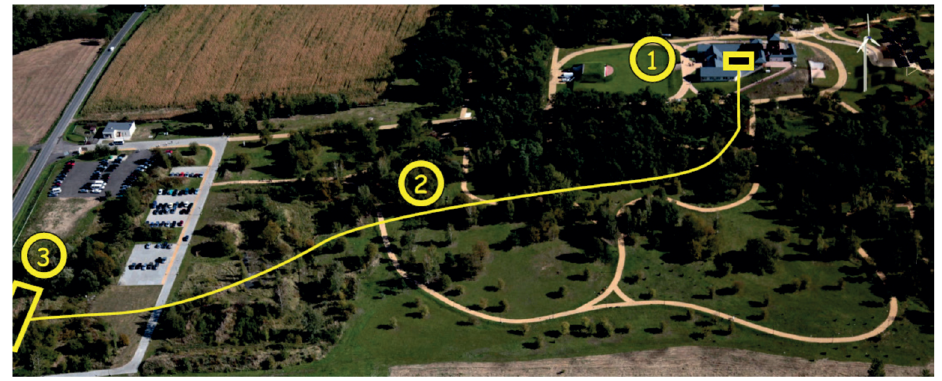
Figure 10. Scheme of a pumped storage power plant for the SBG needs: (1) upper reservoir, (2) pressure pipeline, (3) lower reservoir (existing pond) [77] (source: phot. of Janusz Moczulski, 2013; available thanks to 2013 Pawe ł Kojs’ permission).